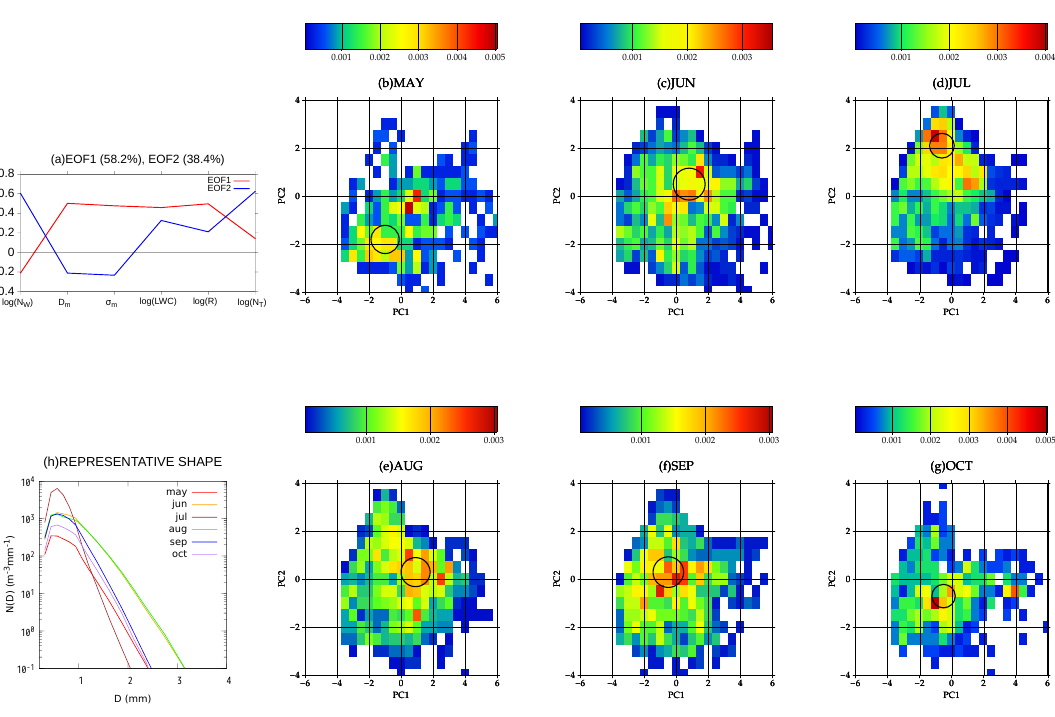
Figure 6. ( a ) The loadings of the first two PCs, represented by EOF1 and EOF2, respectively. ( b )–( g ) Monthly distributions of the first and second component scores (represented by PC1 and PC2, respectively) space for ( b ) May, ( c ) June, ( d ) July, ( e ) August, ( f ) September, and ( g ) October. The circles in each figure show the minimum circle that includes 20% of the total samples in each month. ( h ) The mean DSDs of the samples included within the circles in ( b )–( g ). The monthly distributions of the first and second PC scores (represented by PC1 and PC2, respectivey) space are shown in Figure 6b–g. The signs shown in Figure 6b–g correspond to those of Figure 6a. To extract the representative DSDs for each month, a circle was set at an arbitrary point in PC1–PC2 space. The diameter of the circle was determined, such that the circle included 20% of the total number of points for each month. Subsequently, a search was conducted to find the point with the smallest-sized circle. The smallest circles are shown in each figure of Figure 6b–g. Figure 6h shows the representative DSDs averaged over the DSDs inside the circle for each month. Table 2 represents the mean parameter values for the representative DSDs for each